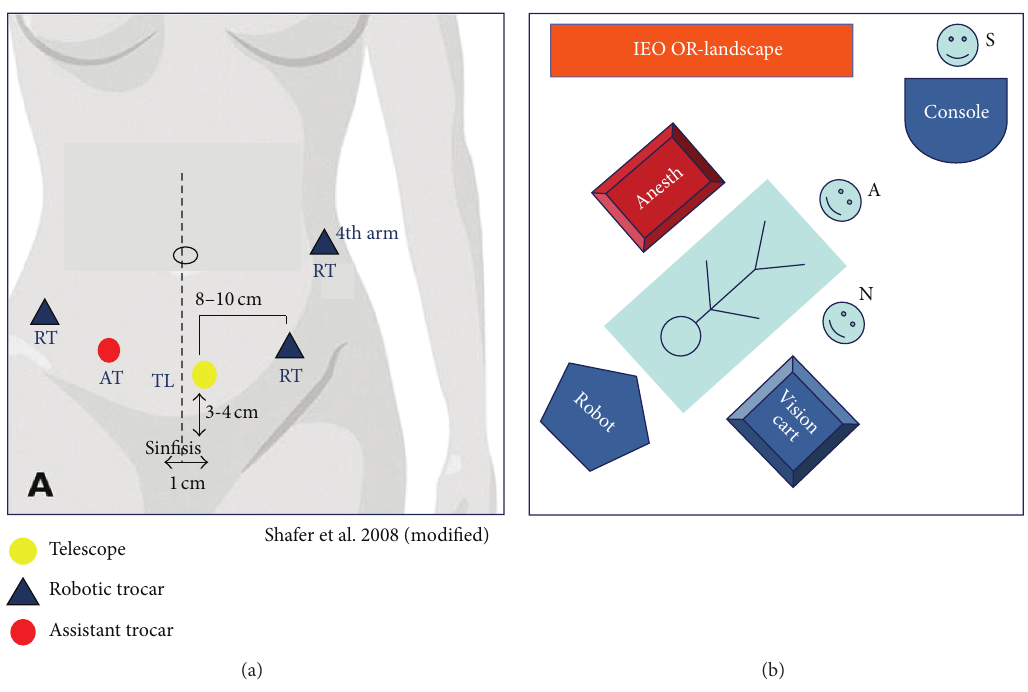
Figure 1: Trocar sites and OR landscape for paraortic lymphadenectomy